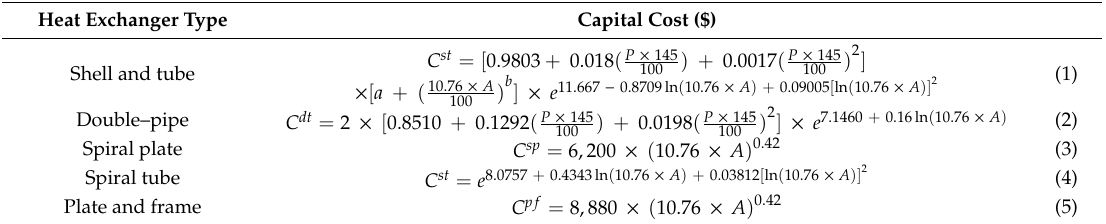
Table 3. The capital cost of heat exchanger types [29] Reproduced from [29], John Wiley & Sons: